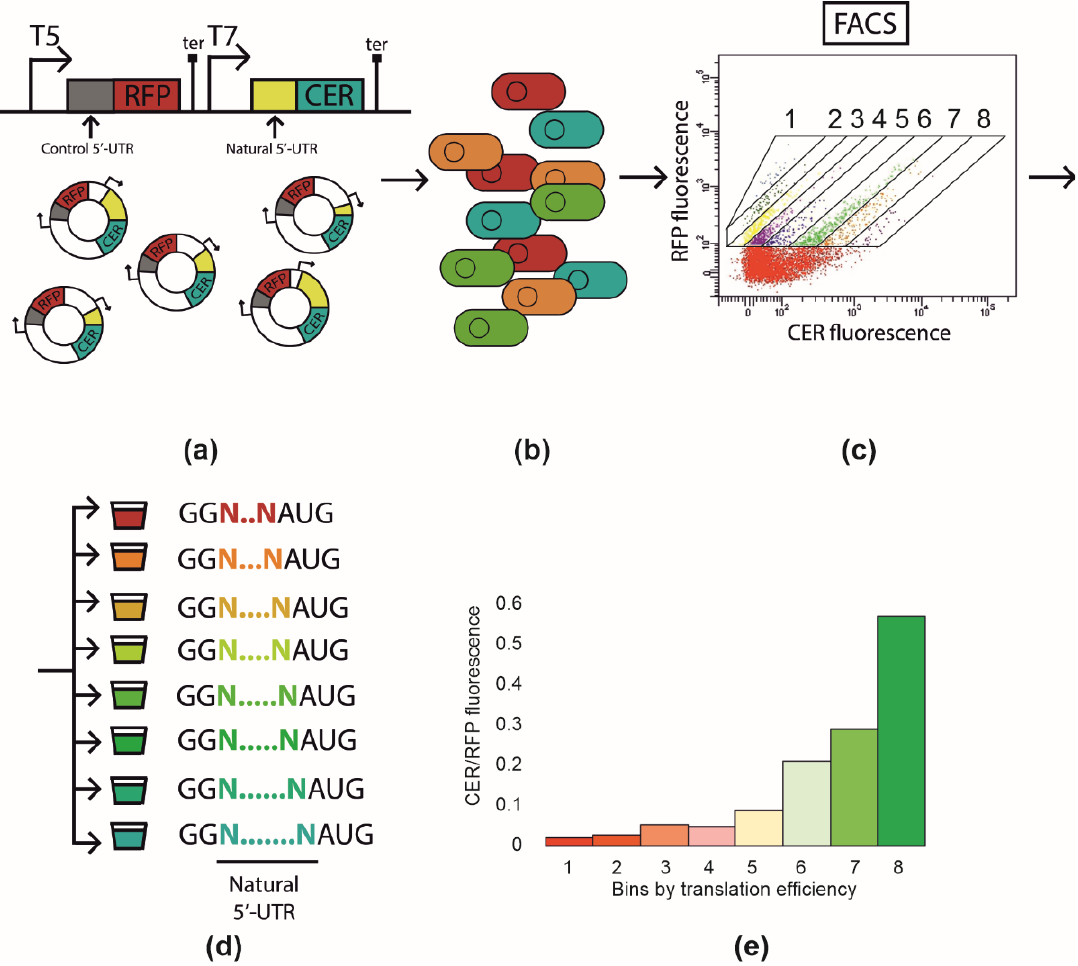
Figure 1. The principal scheme of the Flow-seq experiment. ( a ) Cloning of the DNA fragment containing natural 5′ -UTR into pRFPCER reporter vector in front of cer gene while rfp gene retains its constant 5-UTR. ( b ) Transformation of the entire plasmid library into E. coli BL21 DE3 cells. ( c ) Fluorescence-activated cell sorting with CER/RFP fluorescence intensity ratio. Areas corresponding to fractions 1 – 8 are indicated. ( d ) Collection of cell fractions (1 – 8) according to CER/RFP fluorescence ratio. DNA extraction and amplification of 5′ -UTR containing region followed by next-generation sequencing. ( e ) CER/RFP fluorescence ratio in the cells of fractions from 1 to 8 measured en masse with fluorimeter.